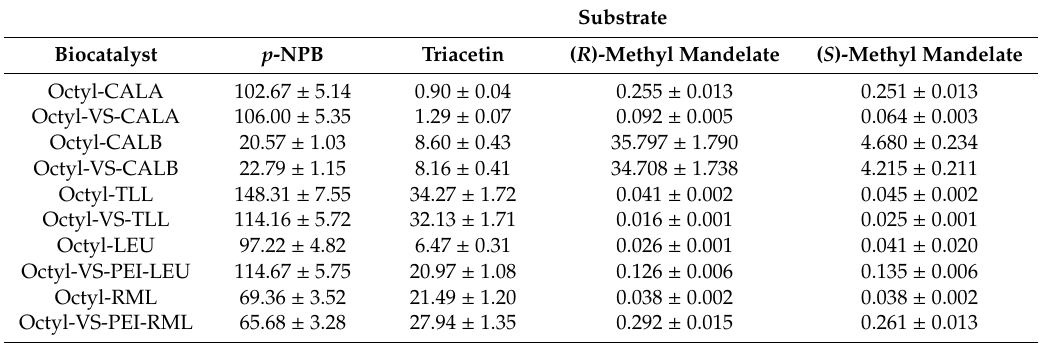
Table 2. Activities of the di ff erent individual lipase immobilized biocatalysts versus di ff erent substrates. Activities are given as U / g. Activities were determined as stated in Methods.